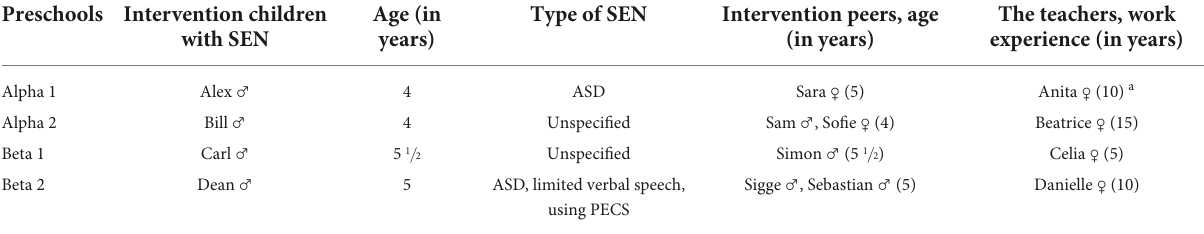
TABLE 2 Participating children and teachers with pseudonyms for the case